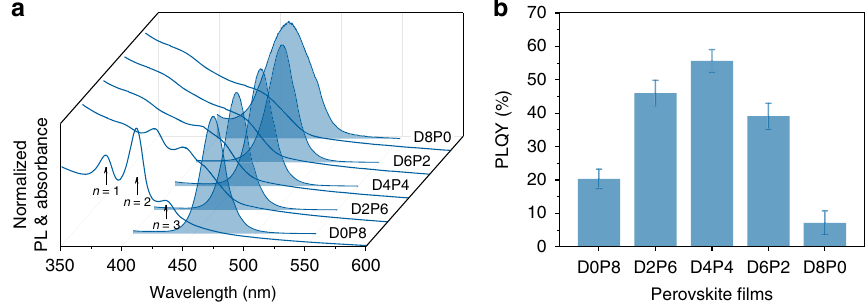
Fig. 2 Optical measurements of the CsPbClBr 2 nanocrystal fi lms. a Steady-state PL and absorption spectra and b PLQYs of the CsPbClBr 2 nanocrystal fi lms obtained with different ratios between DPPABr and PEABr. The error bars correspond to the standard